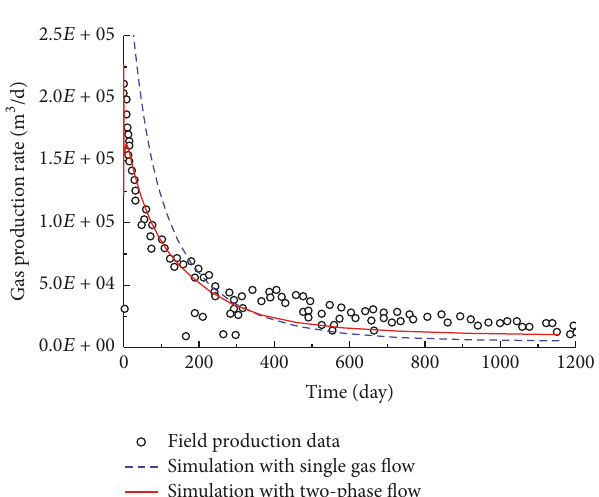
Figure 4: Comparison of numerical simulation and site production in Barnett shale